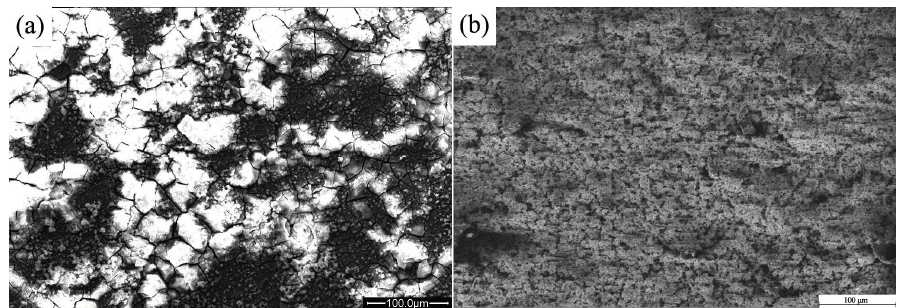
Figure 6. Surface morphologies of uncoated and nHA coated ZK60 samples after immersion test for 7 days. ( a ) Uncoated ZK60; and ( b ) nHA coated